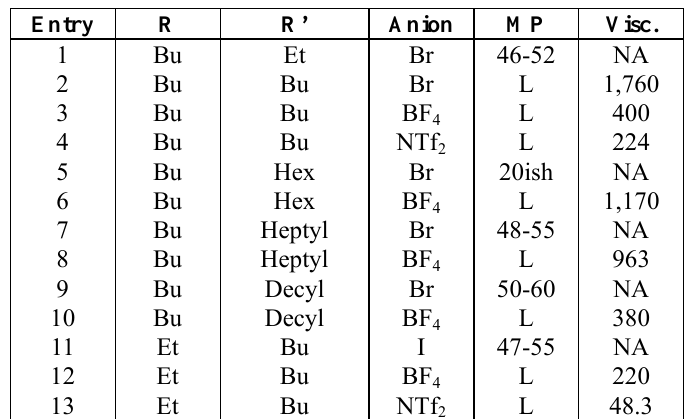
Table 3 . Physical Properties of ionic